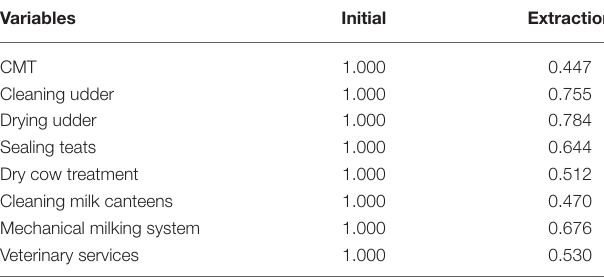
TABLE 10 | Communalities.